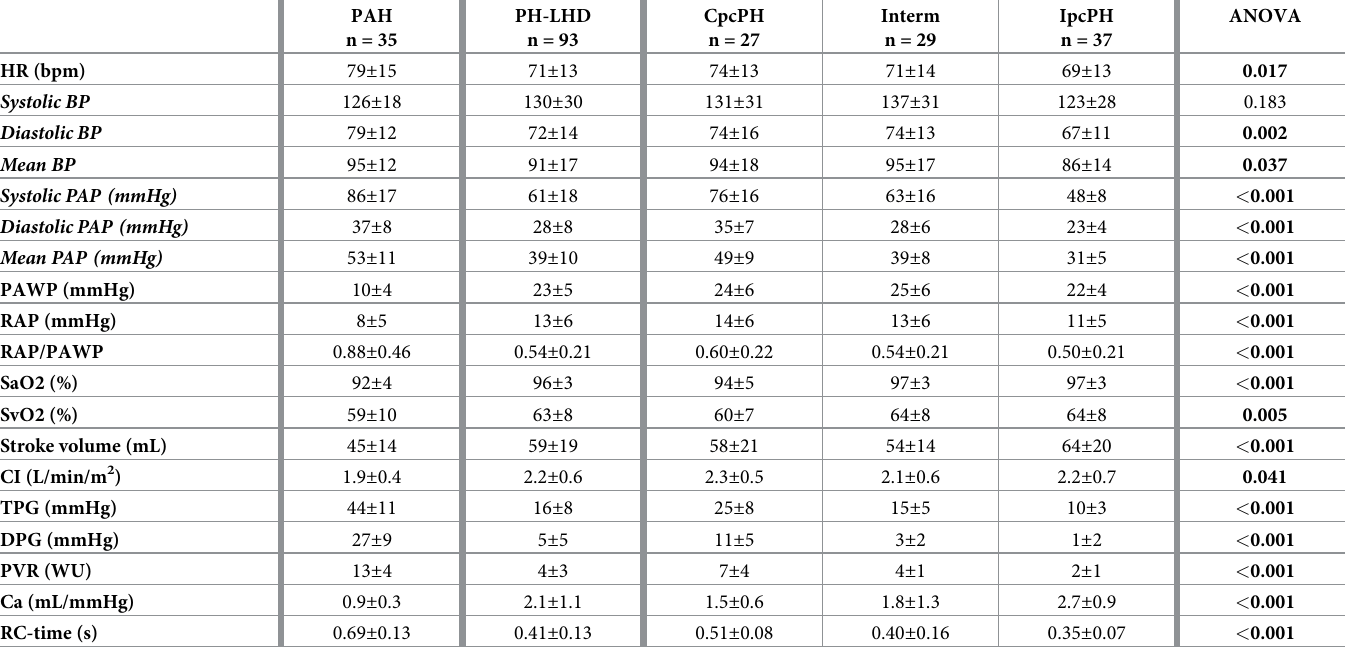
Table 3. Patients’ invasive hemodynamic